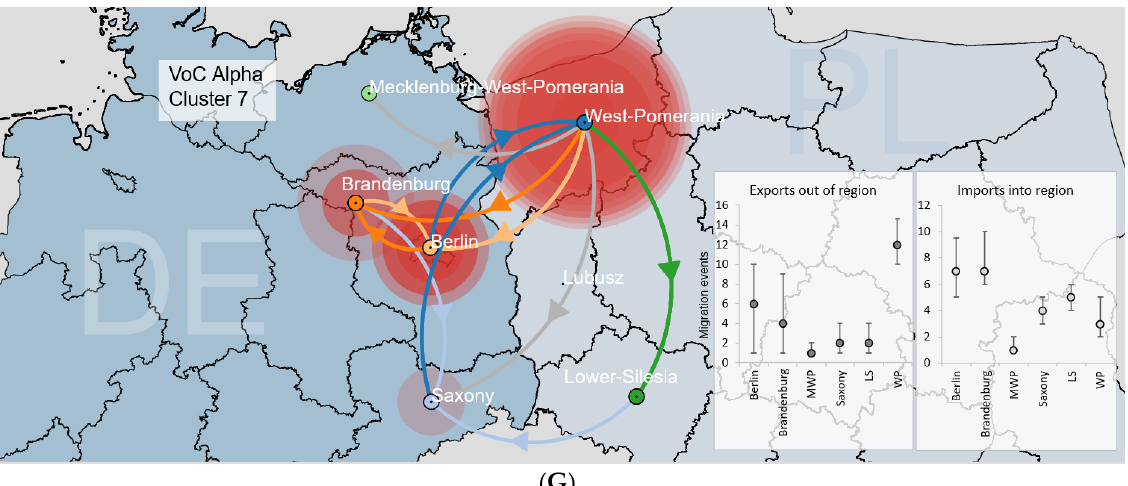
Figure 6. Reconstruction of the dispersal history of the nine largest VOC Alpha Clusters ( A – G ) among the Polish – German border area using the discrete diffusion model. Each of the seven regions is indicated by a (centroid) circle with different colours, and inward movements to a particular location are depicted in the same colour with an arrow. The sizes of the polygons around the sampling centres are proportional to the number of viruses that maintain a specific area. The charts show a median number of transitions out of and into each region, as inferred using a Markov jumps estimation with the 95% HPD intervals shown as lines. All migration events between locations are supported by Bayes Factor values ≥3, except for lines indicated in grey.